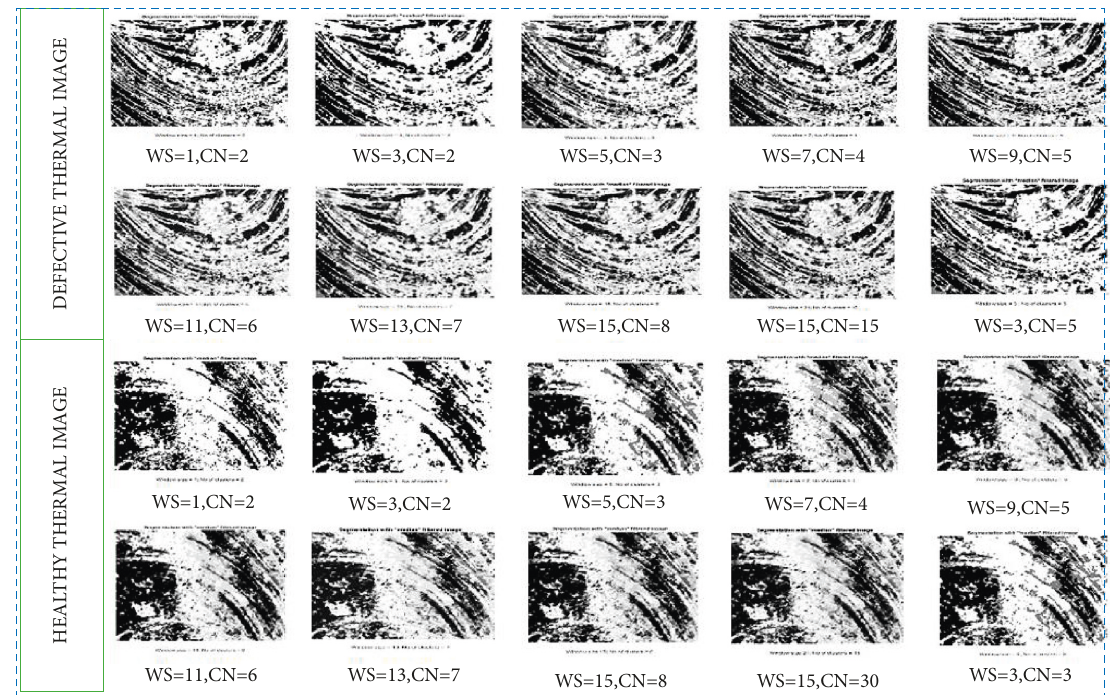
Figure 2: ARKFCM outputs using the median filter for defective and healthy thermal